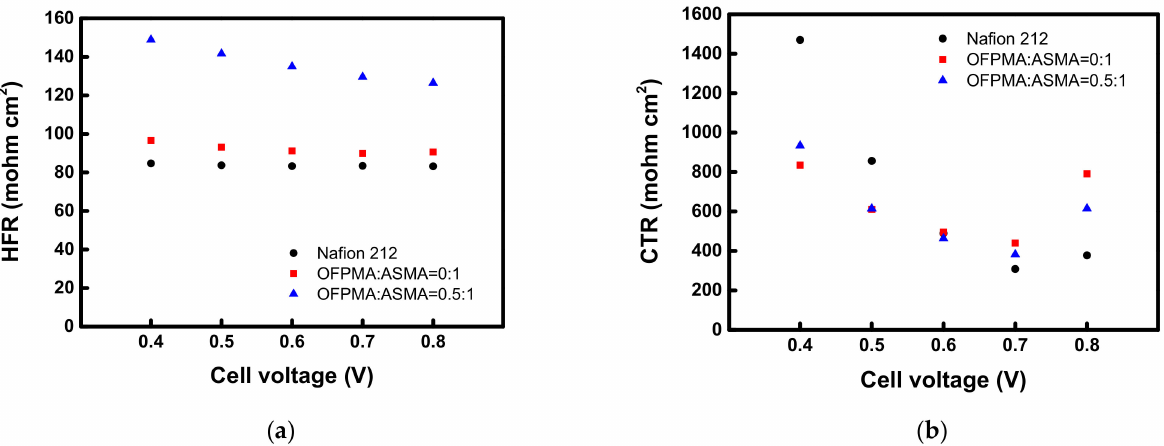
fuel cell performance.